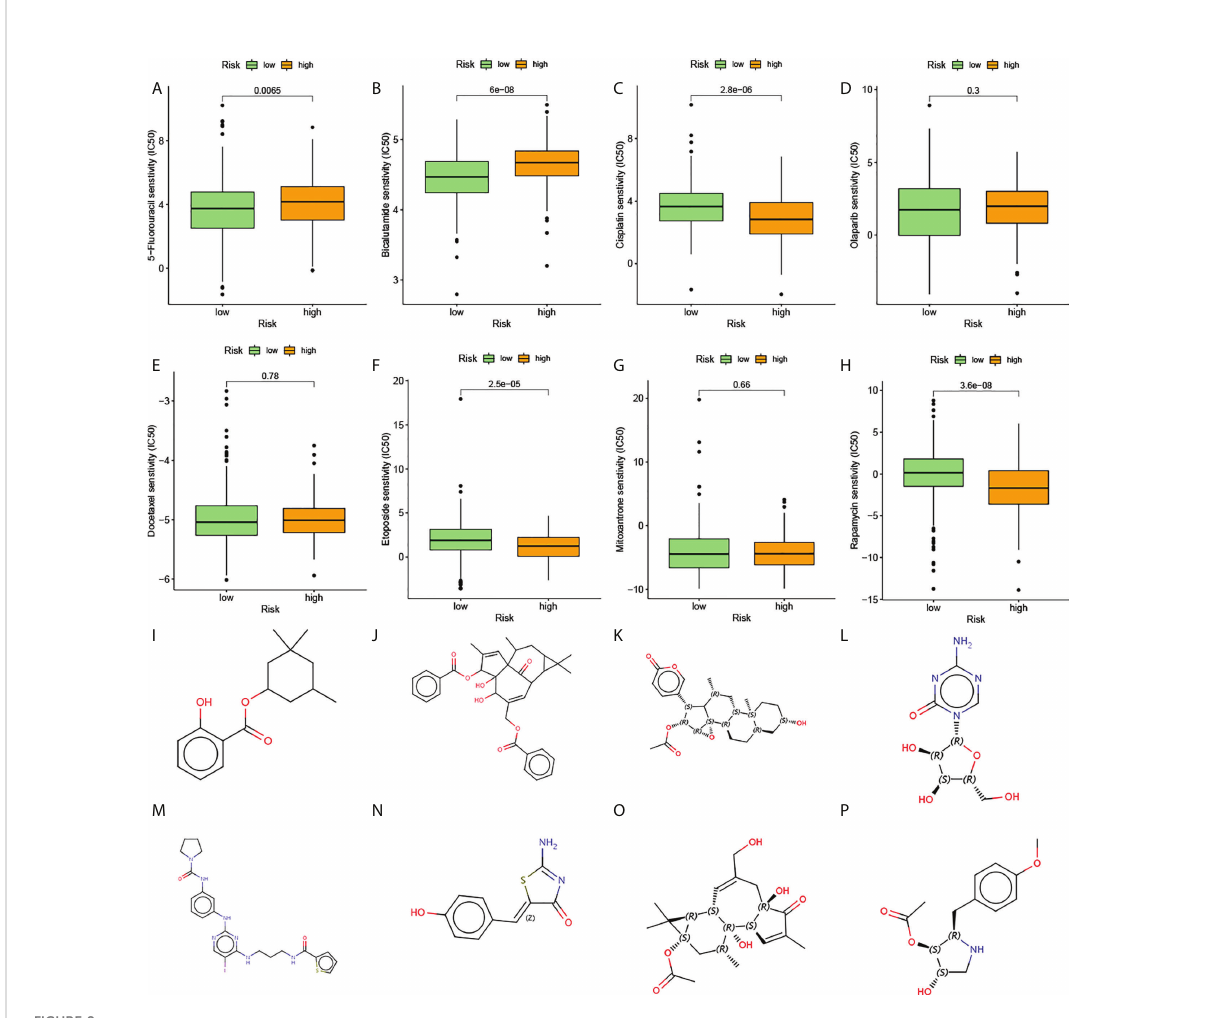
FIGURE 8 The estimation of chemotherapy response and potential therapeutic drugs for prostate cancer. (A – H) The chemotherapy response of two prognostic subtypes for eight common chemotherapy drugs. (I – P) The molecular structure of the eight small-molecule drugs for prostate cancer: (I) homosalate, (J) ingenol, (K) cinobufagin, (L) azacitidine, (M) BX-795, (N) mirin, (O) prostratin, and (P)